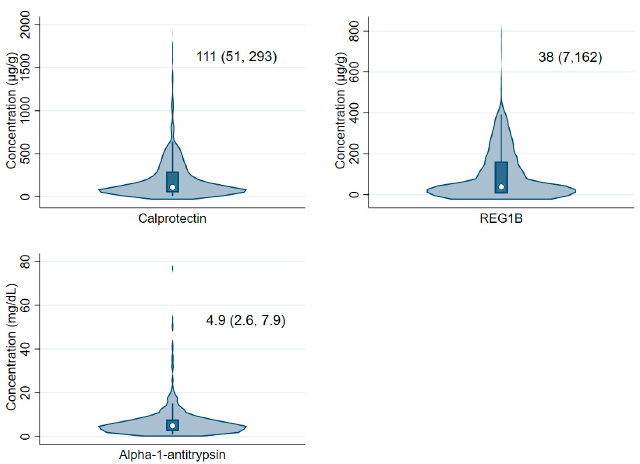
Figure 2. The distribution of concentrations of fecal calprotectin, REG1B, and alpha-1-antitrypsin at 18 months of age.